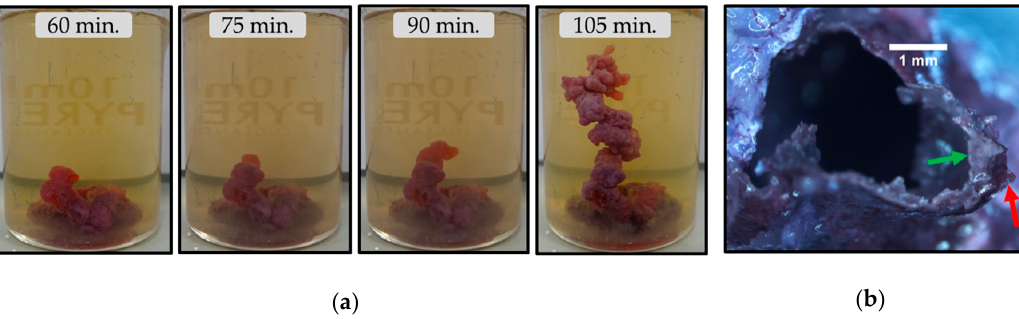
Figure 2. Tubular mineral gardens synthesized by immersing cobalt nitrate pellets in Lake Magadi water. ( a ) Time-lapse images of the growth process (diameter of the beaker is 25 mm); ( b ) cross-section of the tubular membrane.